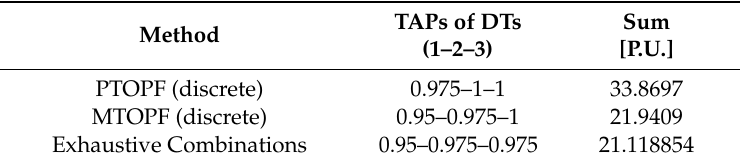
Table 4. Best continuous adjustment of tap